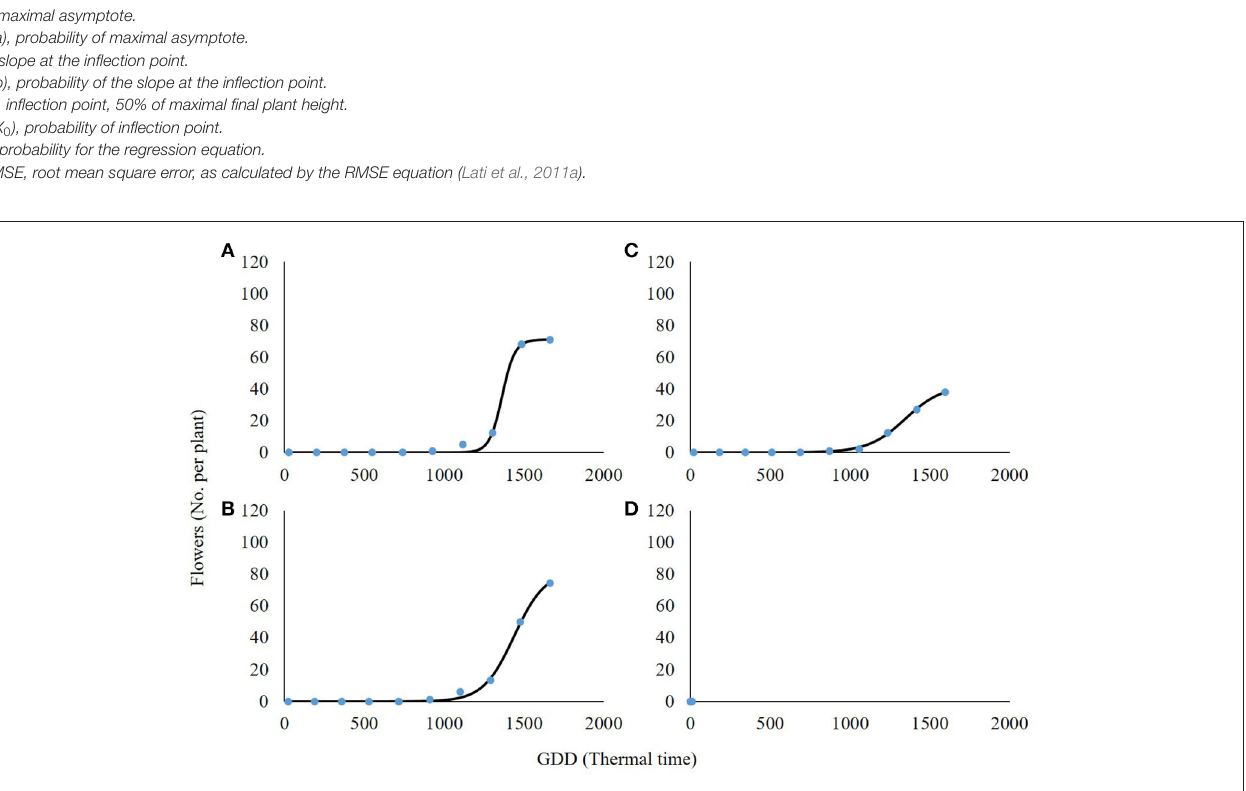
FIGURE 7 | Effect of shade levels (0, 30, 60, and 90%; A–D , respectively) on the final number of flowers per plant of Parthenium hysterophorus . The coefficient for non-linear regressions is given in Table 5